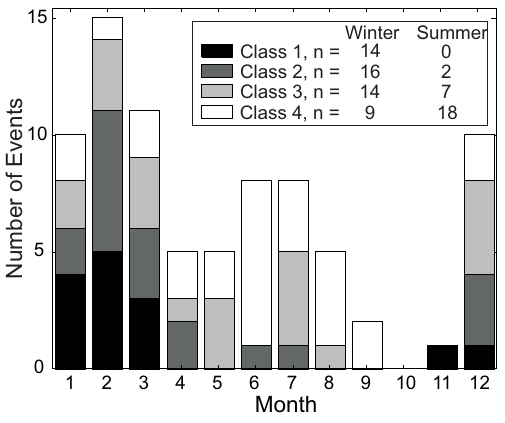
Fig. 7. Number of events per month/season and severity class.